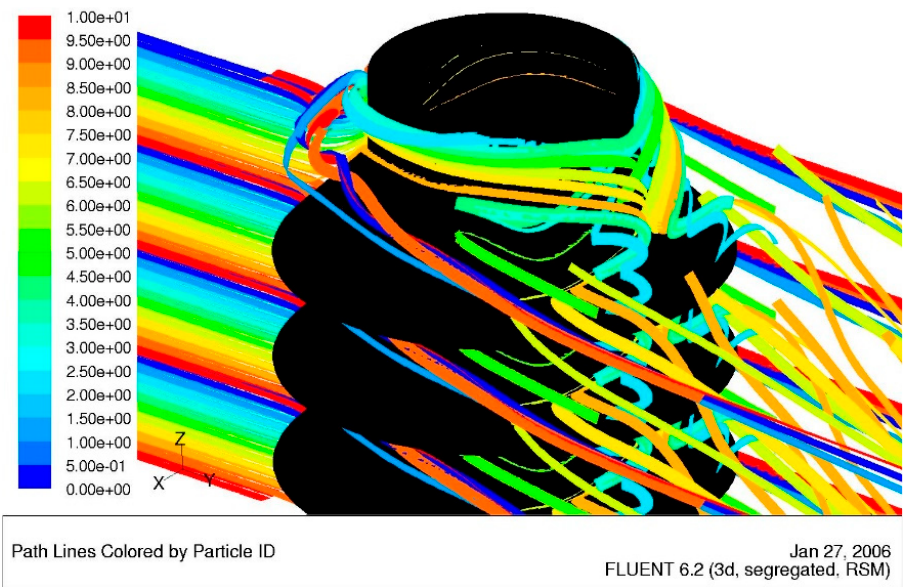
Figure 2. Numerical results using proprietary software. Isometric view of path lines colored by particle ID.